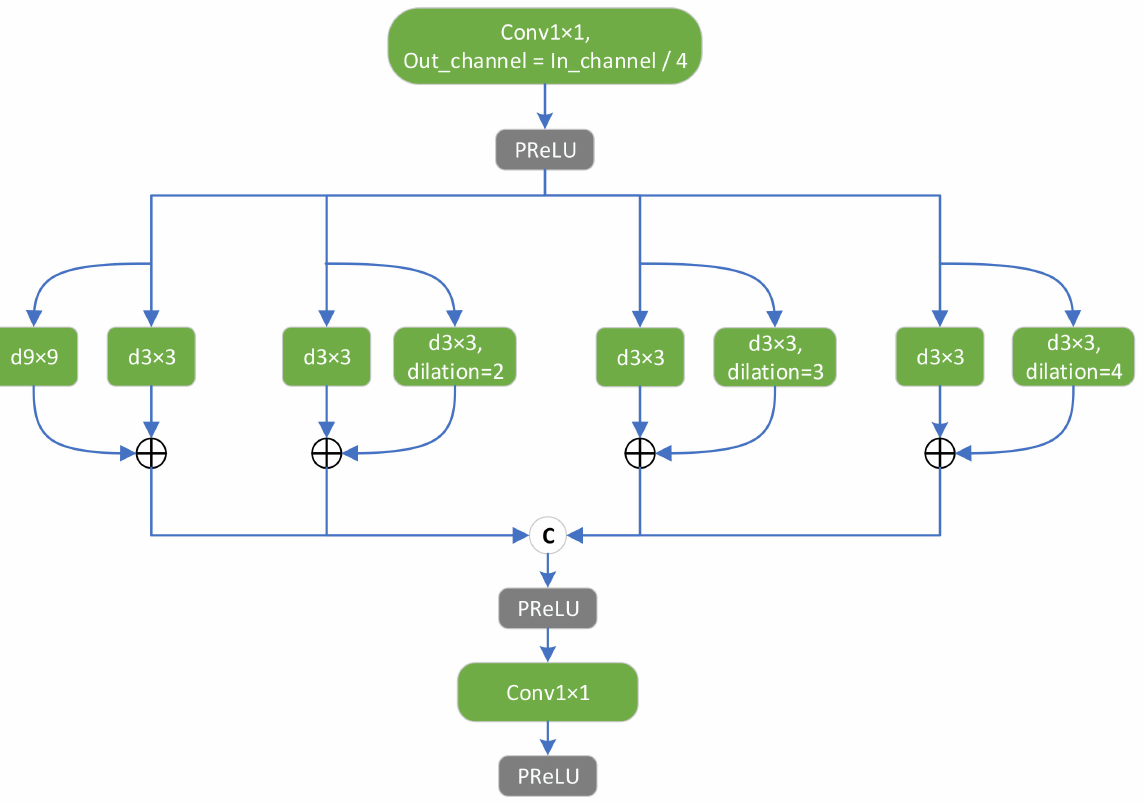
Figure 6. Detailed structure diagram of multiscale large-kernel residual convolution block